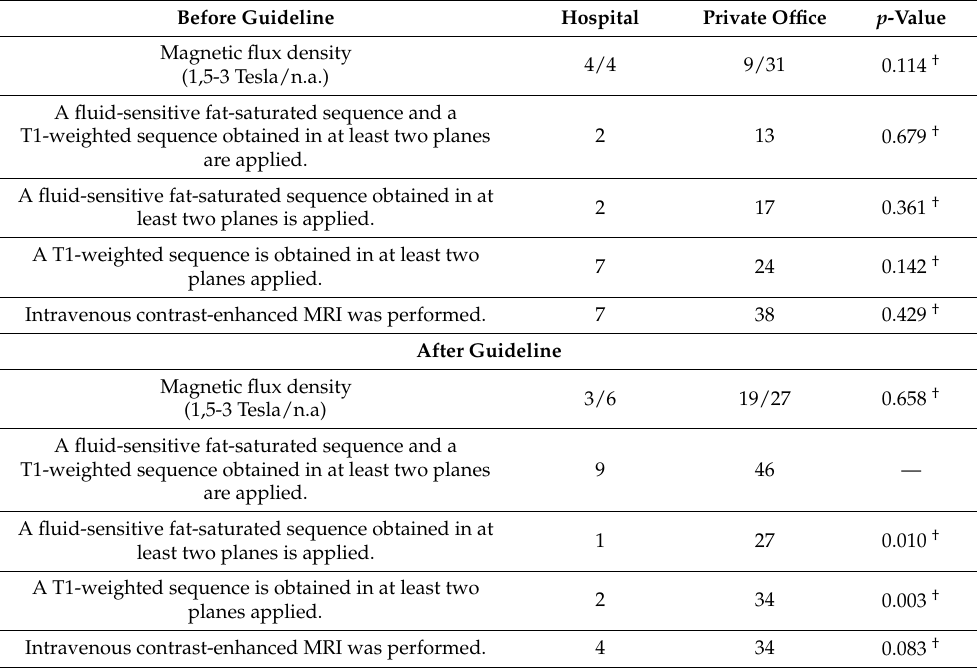
Table 5. Subgroup analysis of technical criteria of the whole collective.